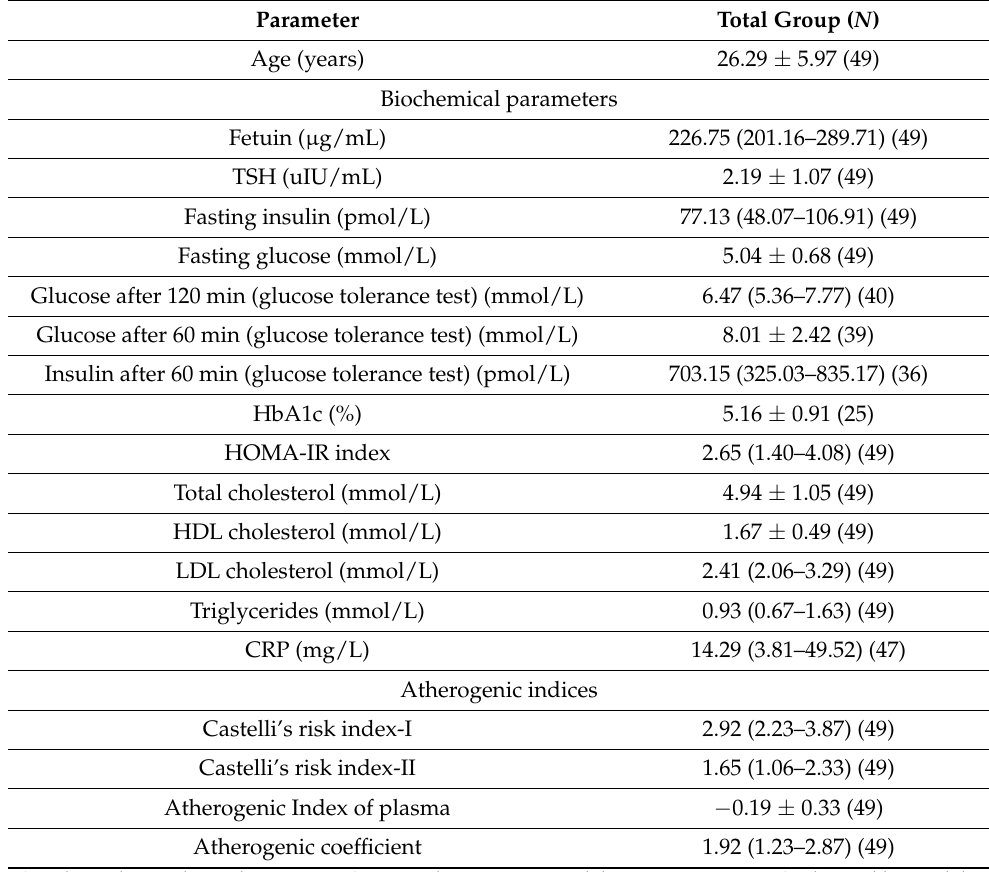
Table 2. Baseline clinical and laboratory characteristic.